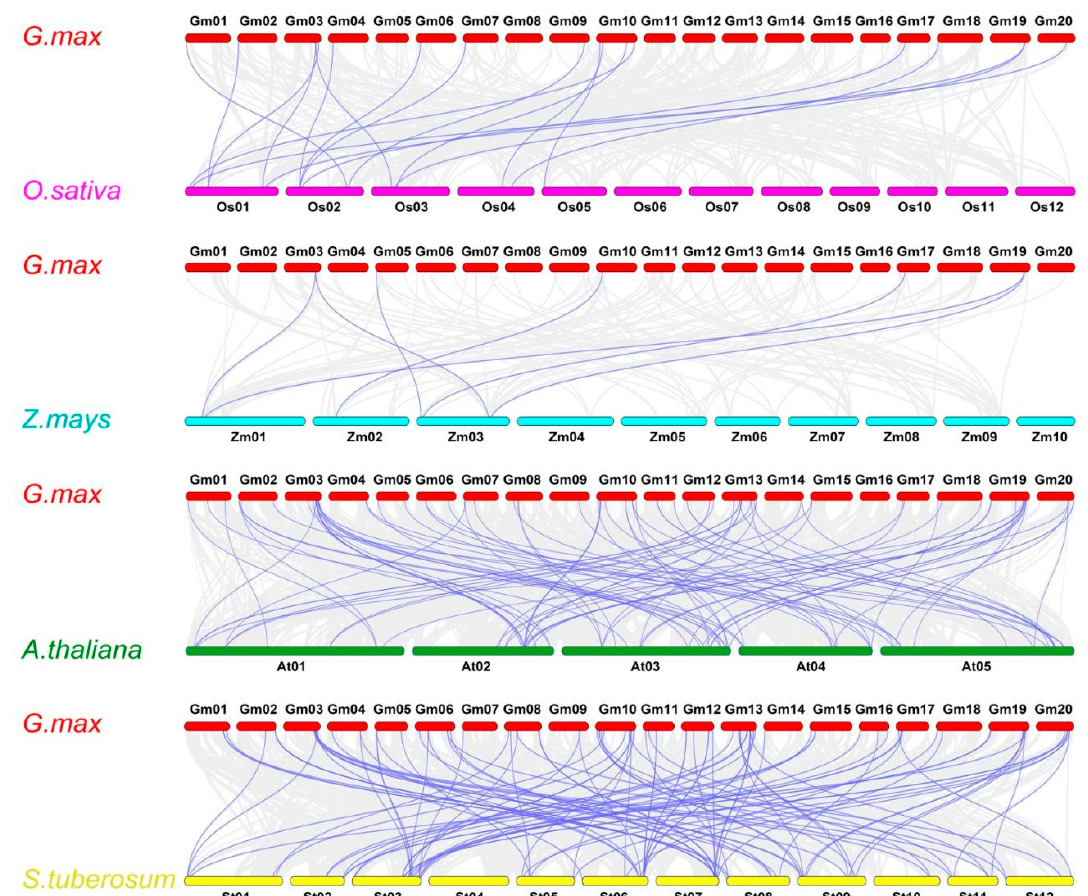
Figure 6. Collinearity analysis of ABC transporter genes between soybean and four other species ( A. thaliana , O. sativa , S. tuberosum , and Z. mays ). The gray curved lines represent the collinear blocks in the whole genome of soybean and other plants, the four species. The purple curved lines represent syntenic ABC transporter gene pairs.